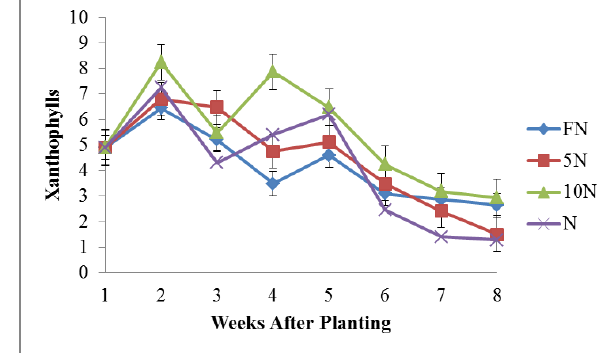
Fig. 4b. The effect of nitrogen nutritional stress on the carotene content of Zea mays measured at different periods